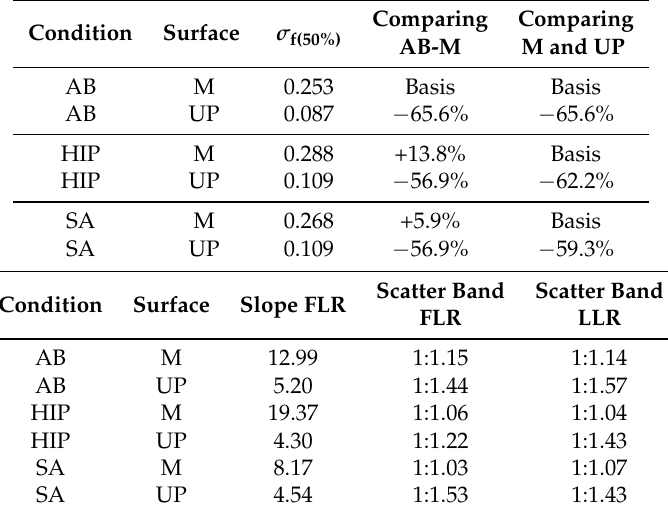
Table 6. High cycle fatigue test